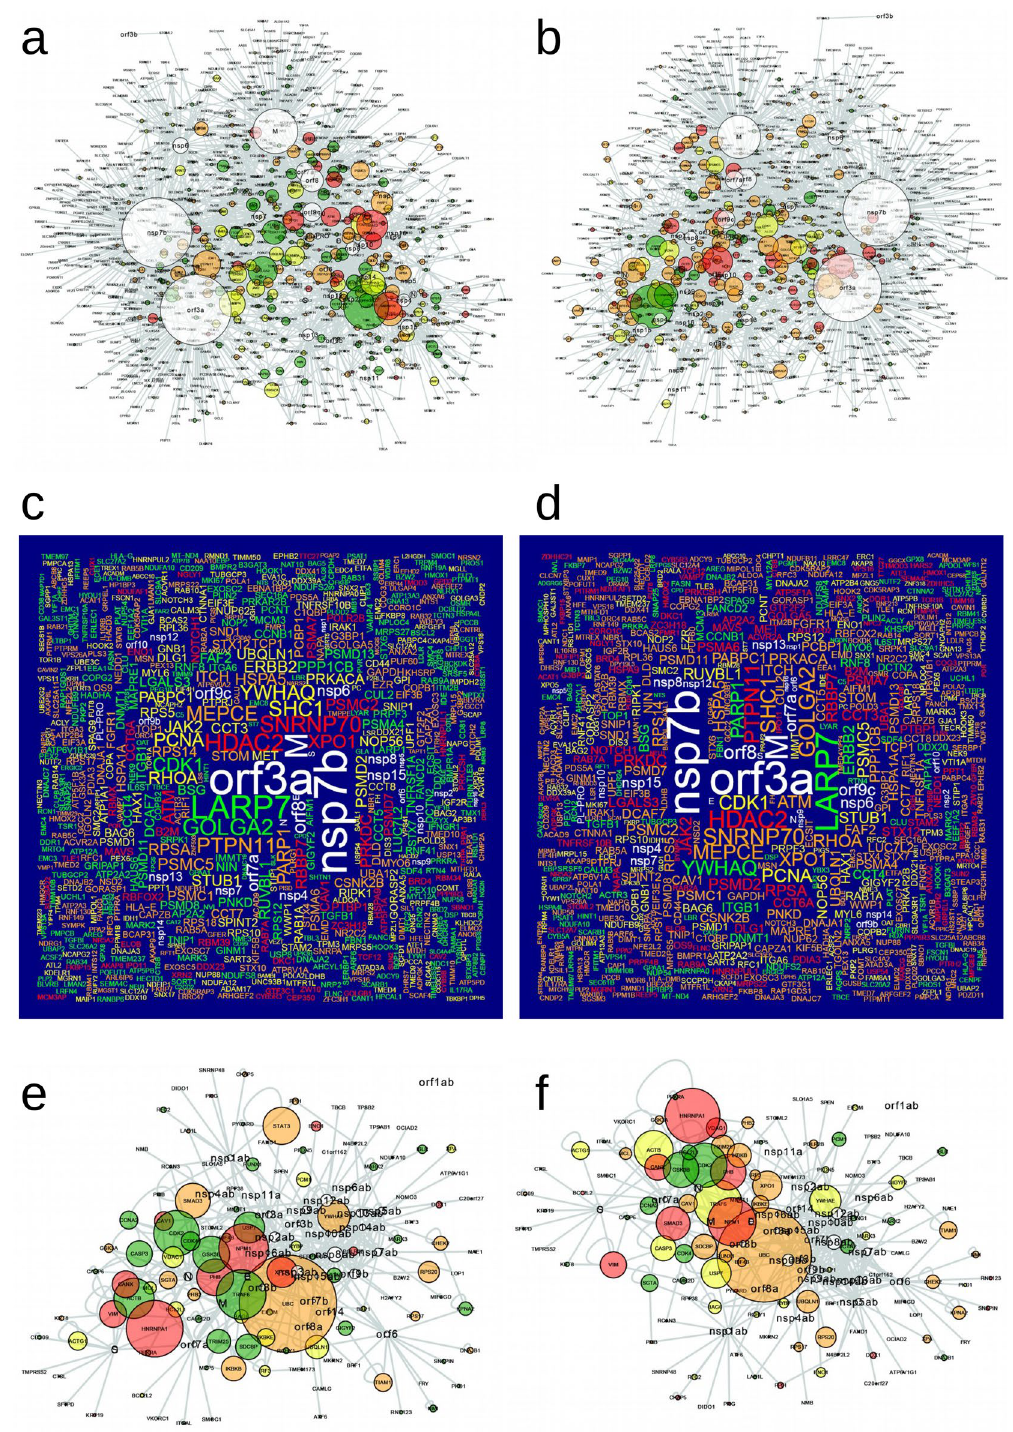
Figure 3. V-H networks and their respective wordclouds. ( a , c ) lung (pneumocytes); ( b ) and ( d ) lung (macrophages), in SARS-CoV-2; ( e , f ) networks in SARS-CoV-1, same order as the previous ones. The wordclouds show the main proteins present in ( a , b ). The size of the circles indicates the connectivity and the color to the Expression value, 1: green (only present at the transcript level), 2: yellow (low amount of protein reported), 3: orange (intermediate amount of protein reported), 4: red (high amount of protein reported) and in white the viral